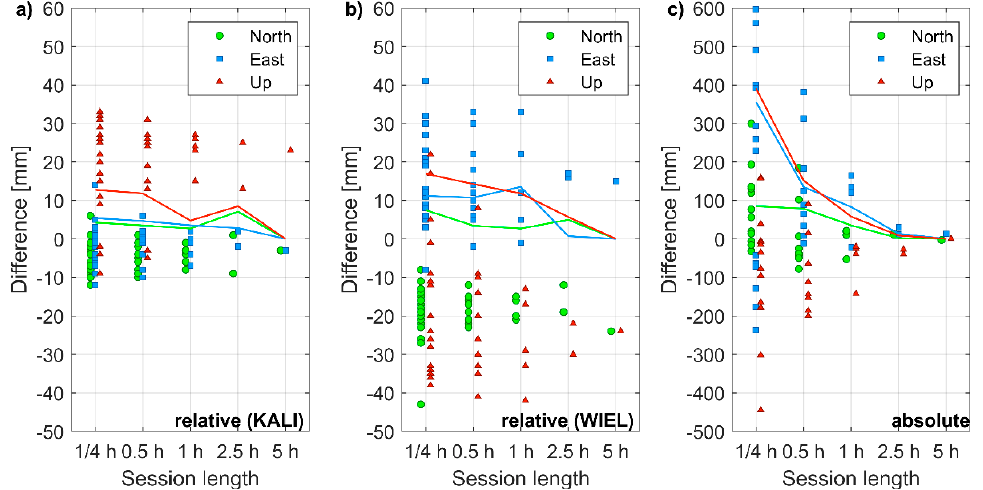
Figure 5. Coordinate differences of point S1 obtained for various session lengths: ( a ) in the relative positioning using the reference station KALI; ( b ) in the relative positioning using reference station WIEL; ( c ) in the absolute positioning.